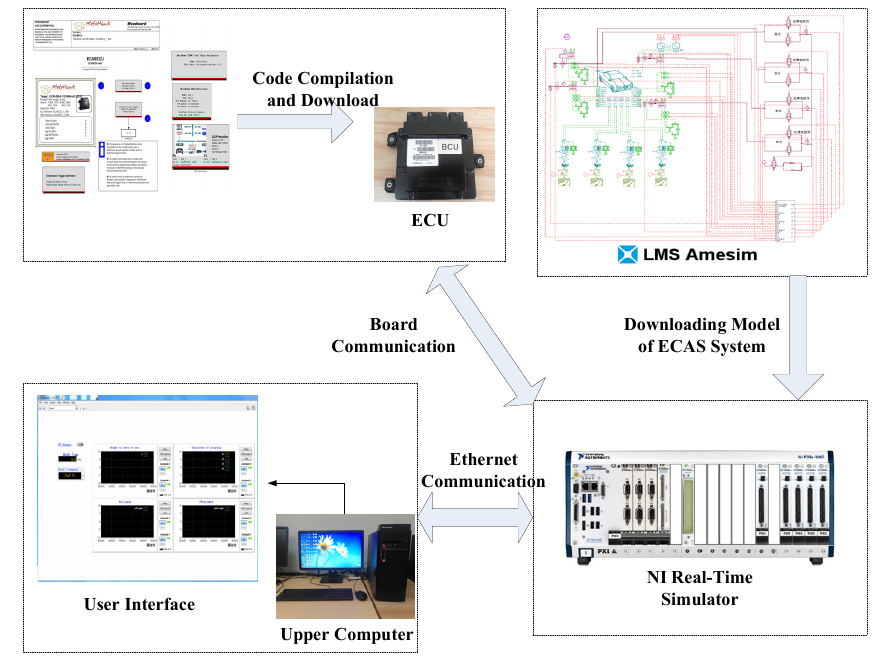
Figure 12. The working principle of HiL test platform.